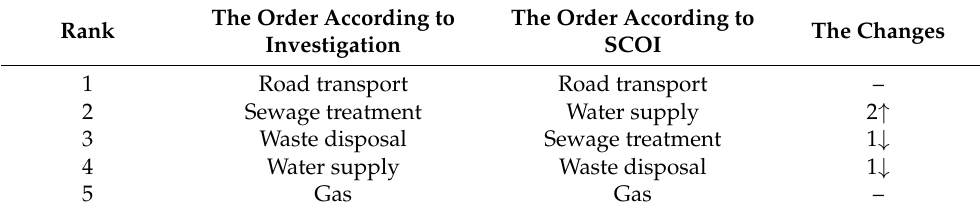
Table 10. The changes in the rank of the major